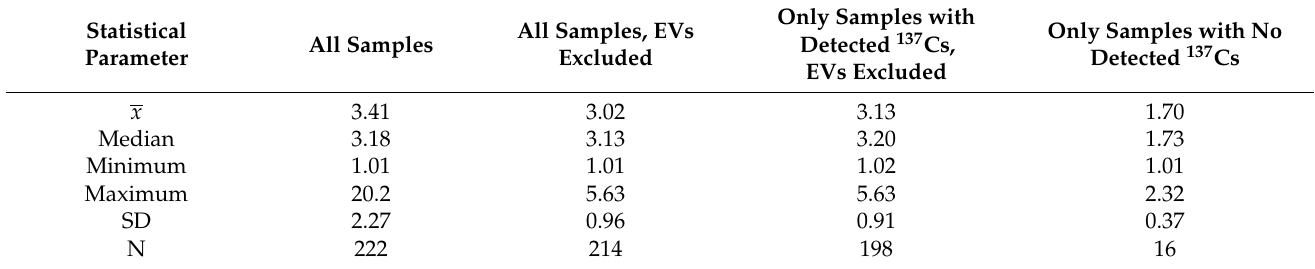
Table 5. Basic statistical parameters of organic matter mass fractions in sediment; fractions are expressed in %; EV, extreme value; x , mean value; SD, standard deviation; N, number of